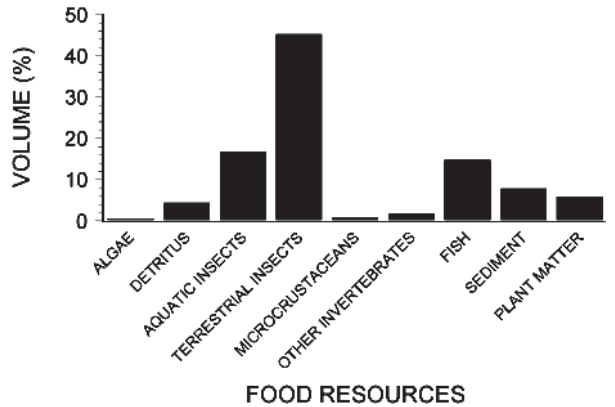
Fig. 3 . Food resource availability, inferred from the volume of items in the stomachs analyzed for all species combined.